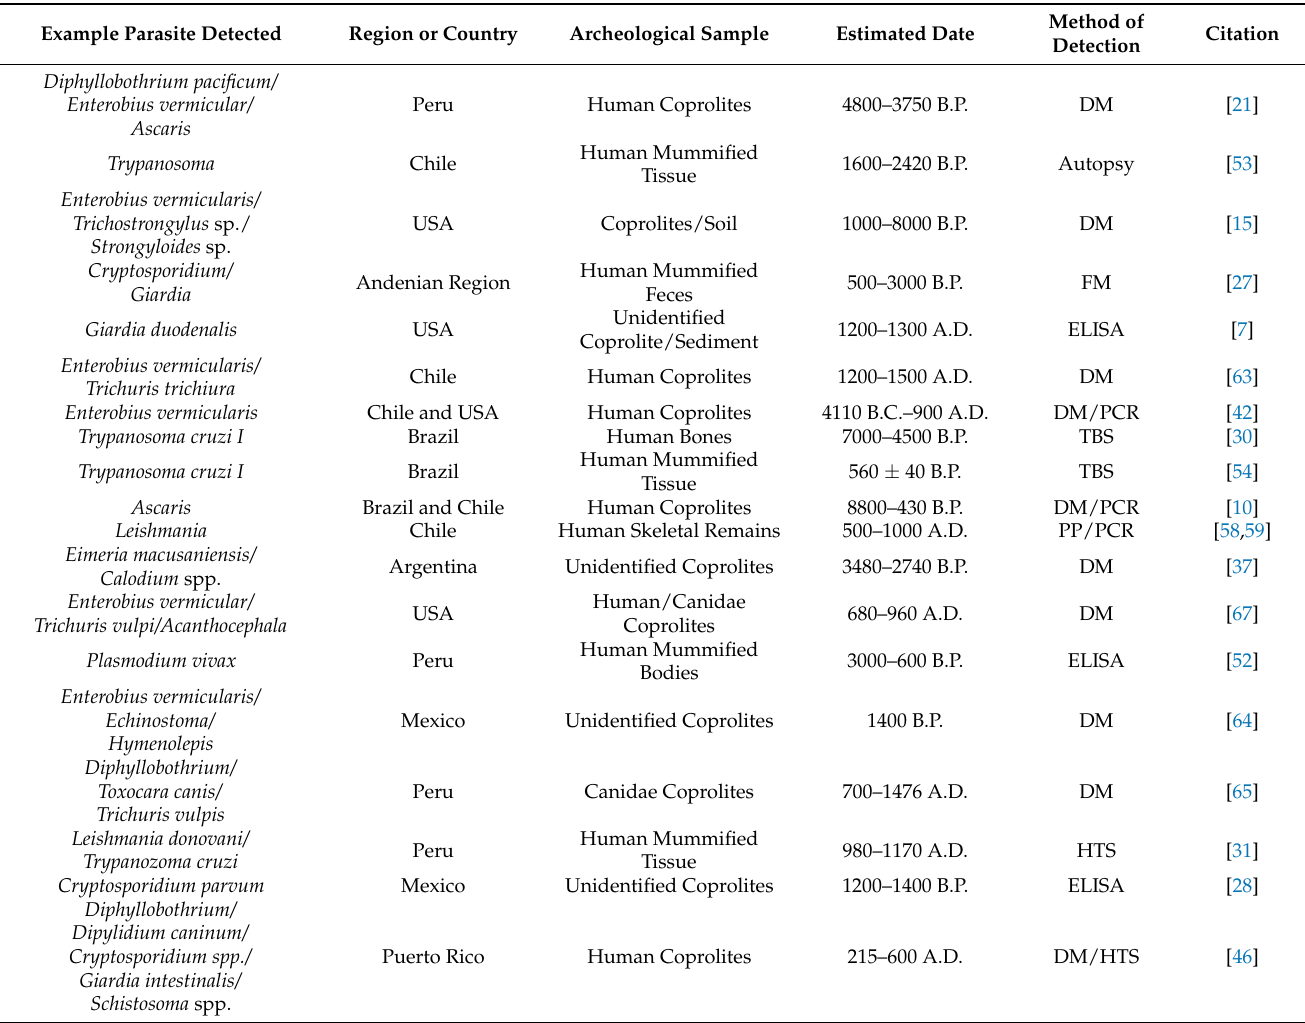
Table 2. Description of parasites identified in prior paleoparasitological studies. Table includes examples of parasites detected, country or region, type of archeological samples, estimated date, and the method of